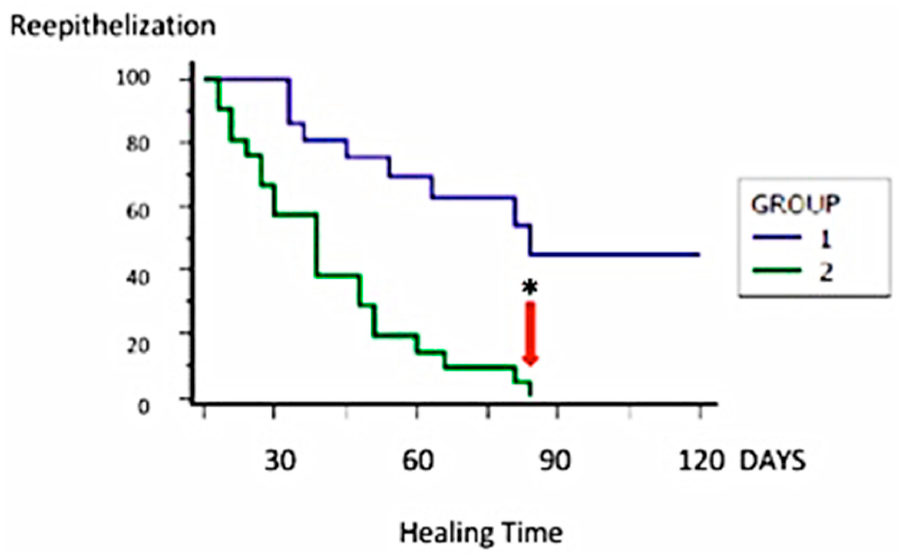
Figure 8. Kaplan–Meier curve depicting the likelihood of patients who have achieved a restitutio ad integrum . Note that the value 0 corresponds to 100% of patients with complete healing. * p < 0.05. After 30 days, the patients who underwent a combined treatment had 96.8% ± 1.5% of reepithelization compared to 78.4% ± 4.4% in Group 1 (HA only; p < 0.01). The in vivo result of a patient affected by a necrotic ulcer (Figure 9A) treated with PRP + HA is reported in Figure 9B. Within 80 days, Group 2 patients had 98.4% ± 1.3% re-epithelization compared to 87.8% ± 4.1% in Group 1 (HA only; p < 0.05). Only 1.6% of Group 2 (PRP + HA) patients who presented an over 20-cm 2 wound size and an over 1-cm wound depth reached complete healing over 45 days. The median duration to complete healing was 45 days. No local recurrence was observed during the follow-up period.